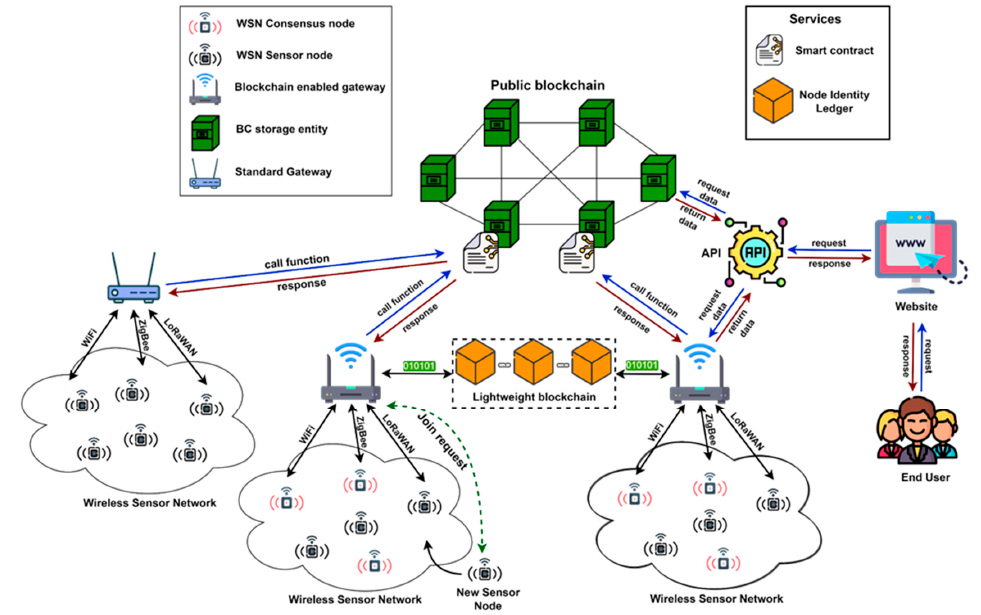
Figure 2. Proposed blockchain WSN architecture for data storage.